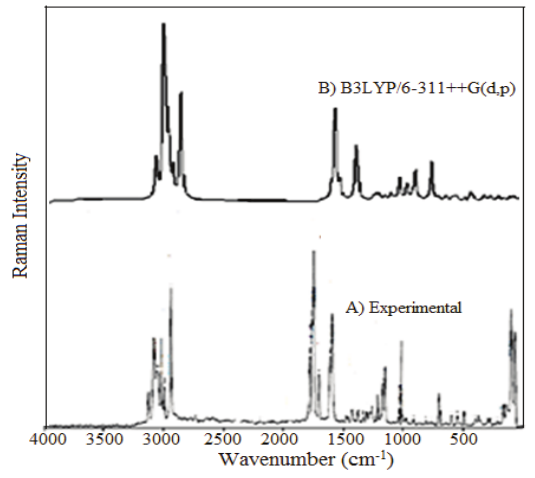
Figure 4 : Experimental and calculated FT-Raman spectra of N